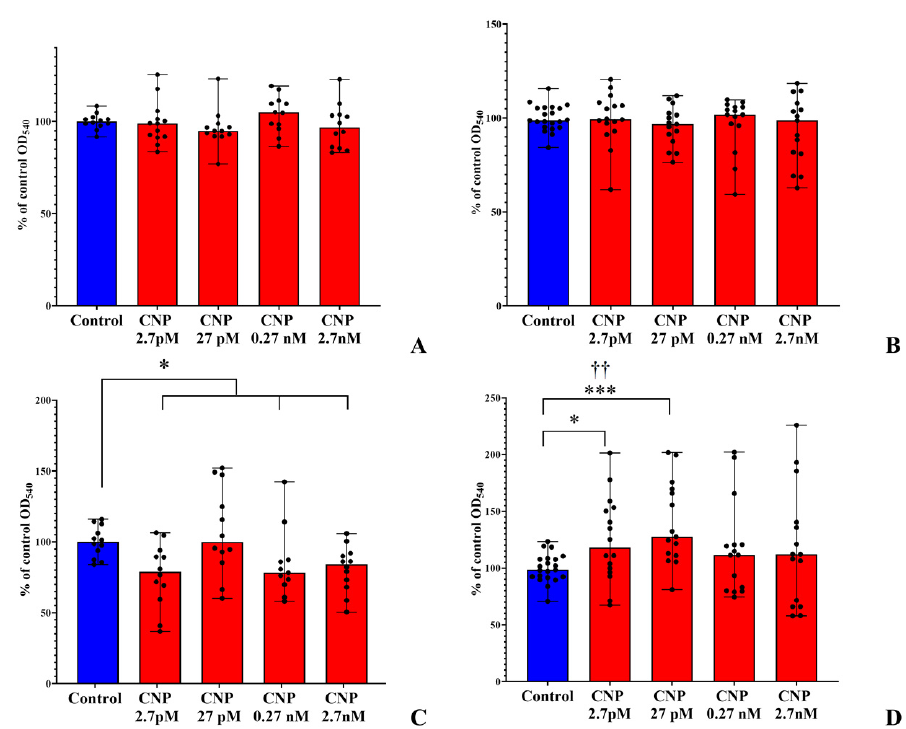
Figure 1. Effects of different CNP concentrations on planktonic cultures and biofilms of S. epidermidis on PTFE cubes. ( A ), 24 h planktonic cultures; ( B ), 72 h planktonic cultures; ( C ), 24 h biofilms; ( D ), 72 h biofilms. Symbols: * represents p < 0.05; *** represents p < 0.001; †† represents q < 0.005; absence of daggers represents q ˃ 0.05.